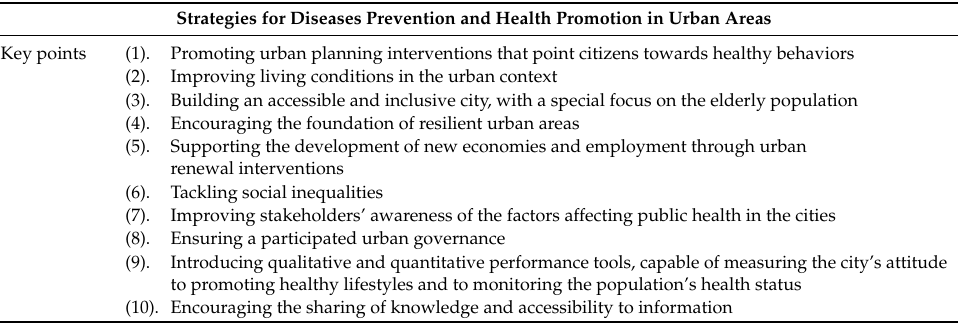
Table 1. The key points included in the Erice 50 Charter